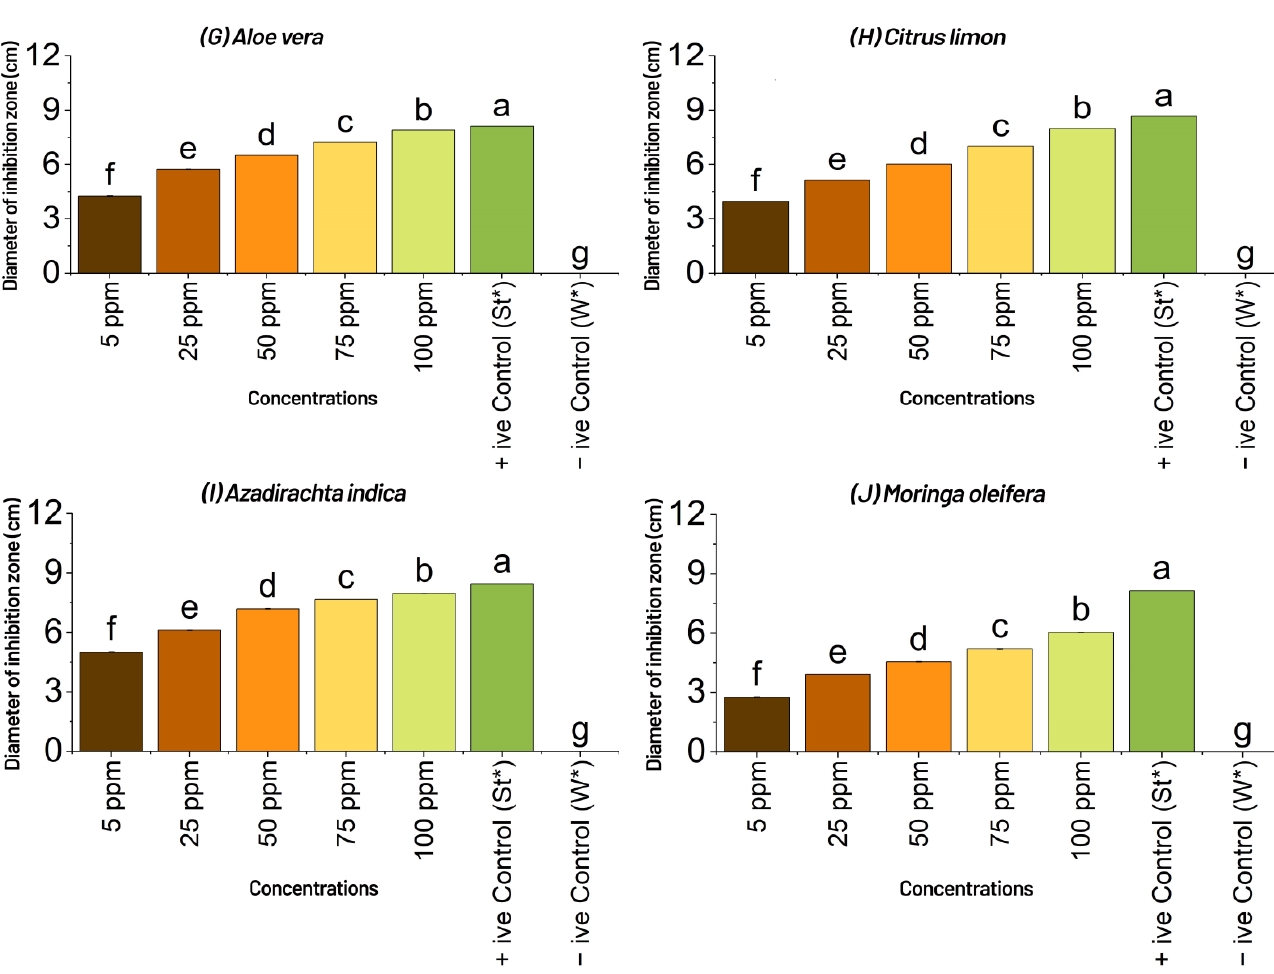
Figure 3. Effect of different concentrations (ppm or µg mL − 1 = microgram per milliliter) of aqueous plant extracts, viz., ( A ) Syzygium aromaticum , ( B ) Curcuma longa , ( C ) Moringa oleifera , ( D ) Azadirachta indica , ( E ) Mangifera indica , ( F ) Mentha piperita , ( G ) Aloe vera , ( H ) Syzygium cumini , ( I ) Prosopis juliflora and ( J ) Citrus limon on the diameter of inhibition zone of Xcm on nutrient agar media plates by disk diffusion technique in vitro. +ive Control (St*) = Streptomycin, which was used as standard, and similarly, − ive control (W*) = water was used to compare the results with aqueous extracts (botanicals) and streptomycin. Means followed by the same letters in each column are not statistically different when compared with least significant difference ( p < 0.05); ppm = parts per million, which can be expressed as milligrams per liter (mg/L), or the measurement of mass of a chemical, or contaminate per unit volume of water; ppm, or µg mL − 1 = micro gram per milli liter, or mg/L, have the same meaning.